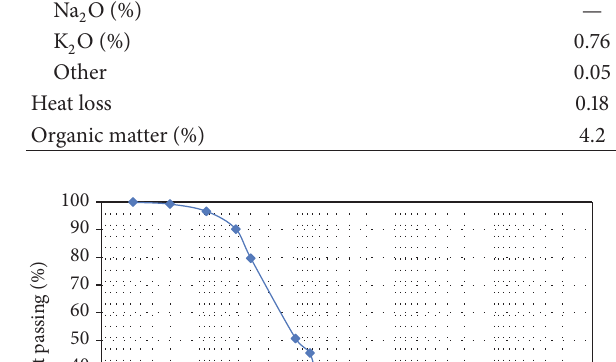
Figure 2: UKM soil particles under SEM. Table 2: Properties of CNT (Graphistrength C100).